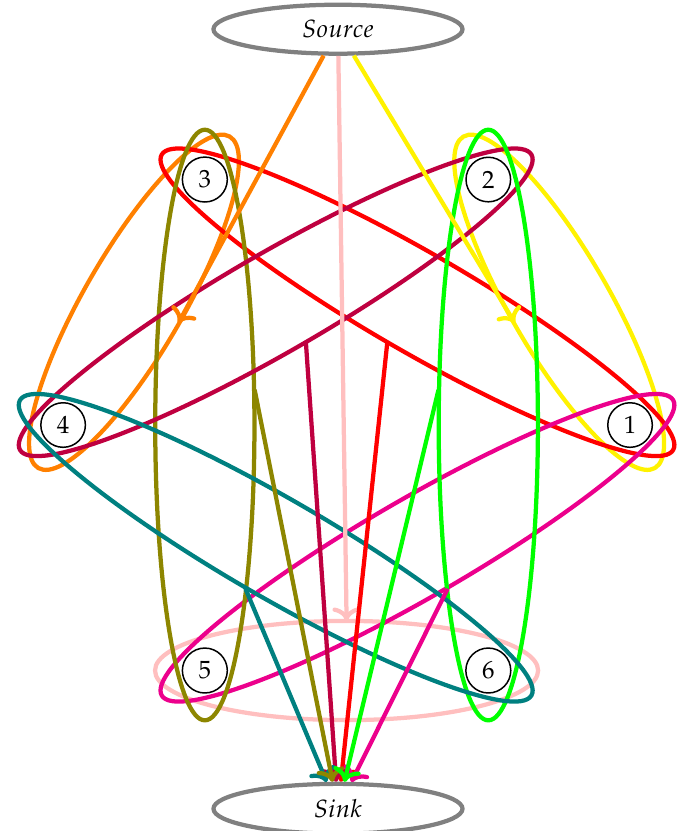
Figure 4. The resolvable network of the pigeon hole problem with 3 pigeons and 2